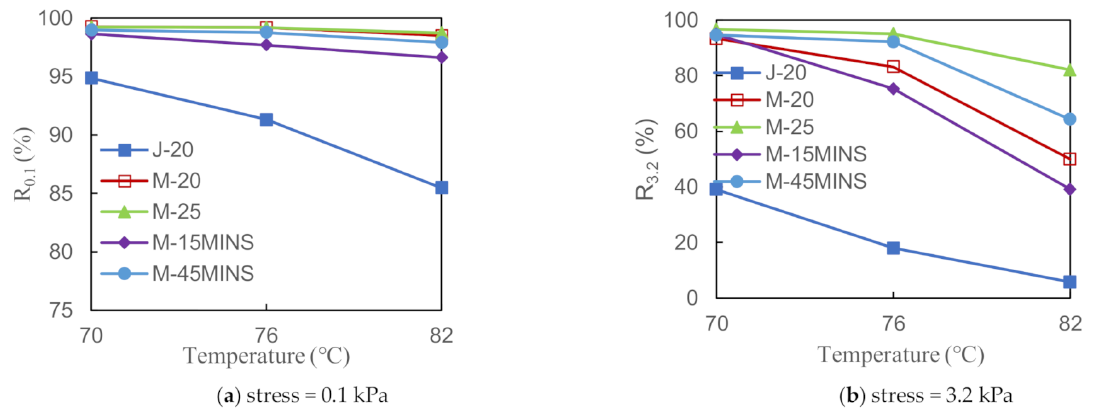
Figure 5. Influence of temperature on recovered strain (R) of asphalt binder at different stress levels.